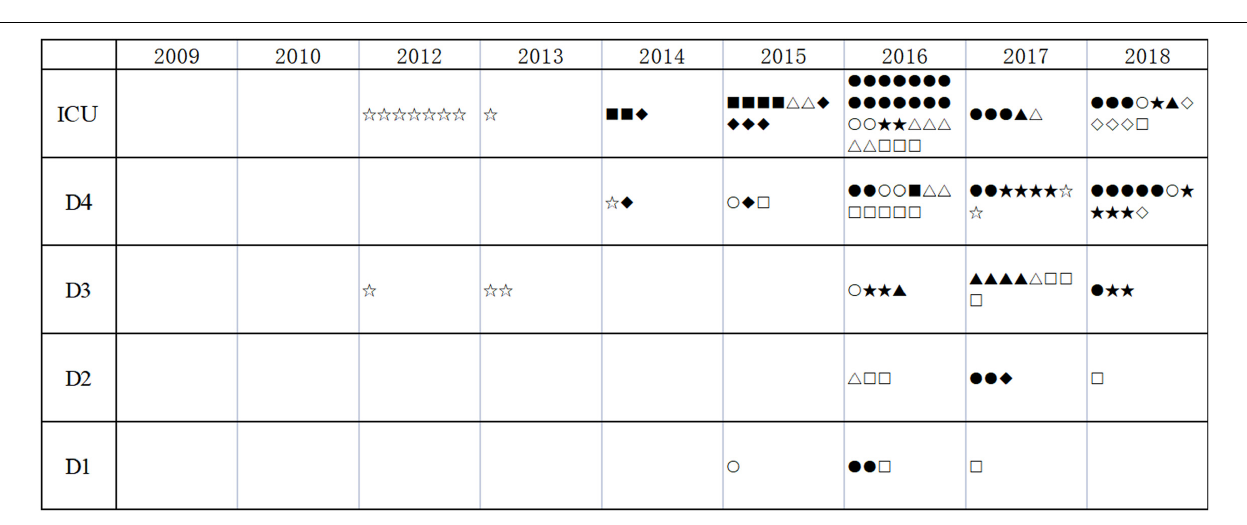
FIGURE 3 | The distribution of KPC-2-producing CRKP ST11. ICU, intensive care unit; D1 to D4, four wards of the respiratory department. Clinical isolates with different types are indicated by various symbols ( (cid:115) : A1; (cid:116) : A2; (cid:117) : A3; (cid:81) : A4; (cid:110) : A5; (cid:108) : A6; (cid:164) : A7; (cid:72) : A8; (cid:95) :